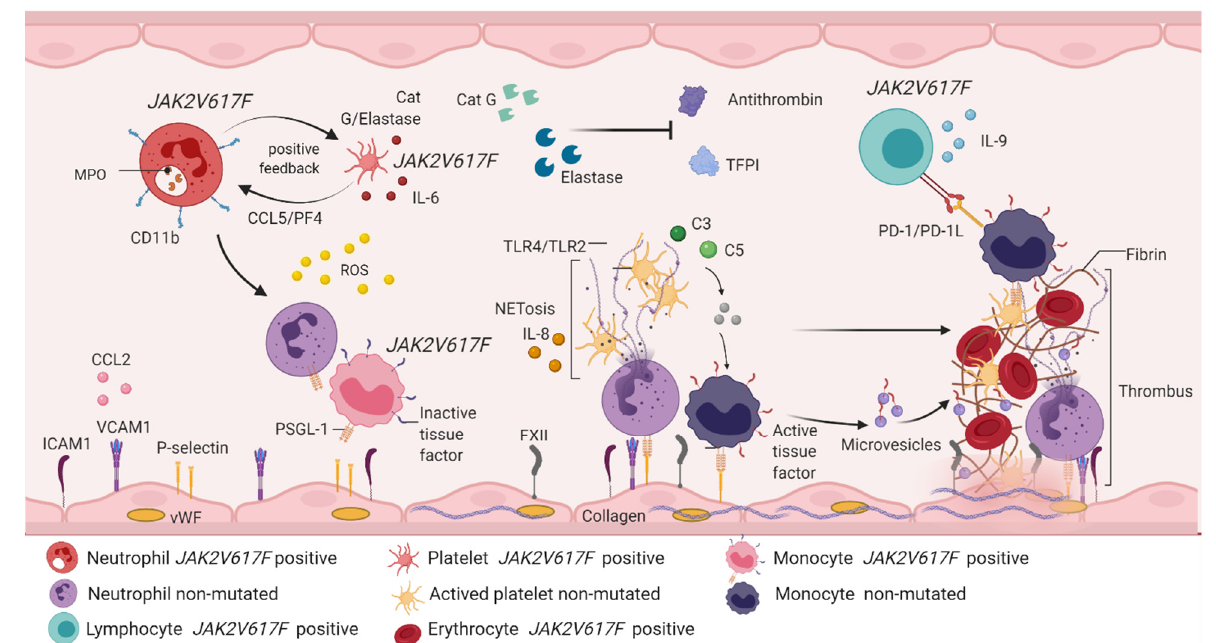
Figure 5. Immunothrombosis involves the participation of hematopoietic cells and immune system cells. JAK2 V617F positive neutrophils express CD11b on the cell surface and secrete enzymes such as MPO, cathepsin G and elastase. The release of cathepsin G and elastase activates CCL5/PF4 signaling in JAK2 V617F positive platelets, which is an interaction that creates positive feedback between platelets and neutrophils, and favors the production of IL-6 and ROS. Free cathepsin and elastase inhibit the function of antithrombin and plasma TFPI, contributing to the thrombotic phenotype. Unmutated neutrophils are activated by the action of ROS, which recruit and activate monocytes with PSGL-1 expression and inactive tissue factor. Both cells manifest rolling and endothelial adhesion by binding adhesion molecules expressed in endothelial cells (ICAM1, VCAM1, P-selectin, CCL2 and FXII). Simultaneously, endothelial cells are activated by the action of ROS, releasing vWF and collagen, thus forming a platelet–monocyte–neutrophil interaction, which favors the discharge of genetic and protein material from the neutrophil, starting with NETosis. This brings with it the expression of IL-8 and activation of TLR4/TLR2 in platelets, a fact that allows the expression of receptor glycoproteins and, therefore, platelet aggregation. In NETosis, erythrocytes are recruited and release hemoglobin and increase ROS production. The complement system is active in response to activation of immune cells, especially through the action of C3 and C5, which induces signaling from JAK2 V617F positive monocytes and non-mutated monocytes. JAK2 V617F positive monocytes express PD-1L, which immediately activates PD-1 in JAK2 V617F lymphocytes, a mechanism responsible for the evasion of the immune response described in chronic myeloproliferative neoplasms. Recruitment and activation of immune and hematopoietic cells benefits the conversion of fibrinogen into fibrin, giving rise to thrombus formation, the main factor involved in vascular complications described in myeloproliferative neoplasms. MPO: myeloperoxidase; CCL5: chemokine ligand 5; PF4: platelet factor 4; IL-6: interleukin 6; ROS: reactive oxygen species; TFPI: plasma tissue factor inhibitor; PSGL-1: P-selectin ligand 1; ICAM-1: intercellular adhesion molecules 1; VCAM-1: vascular cell